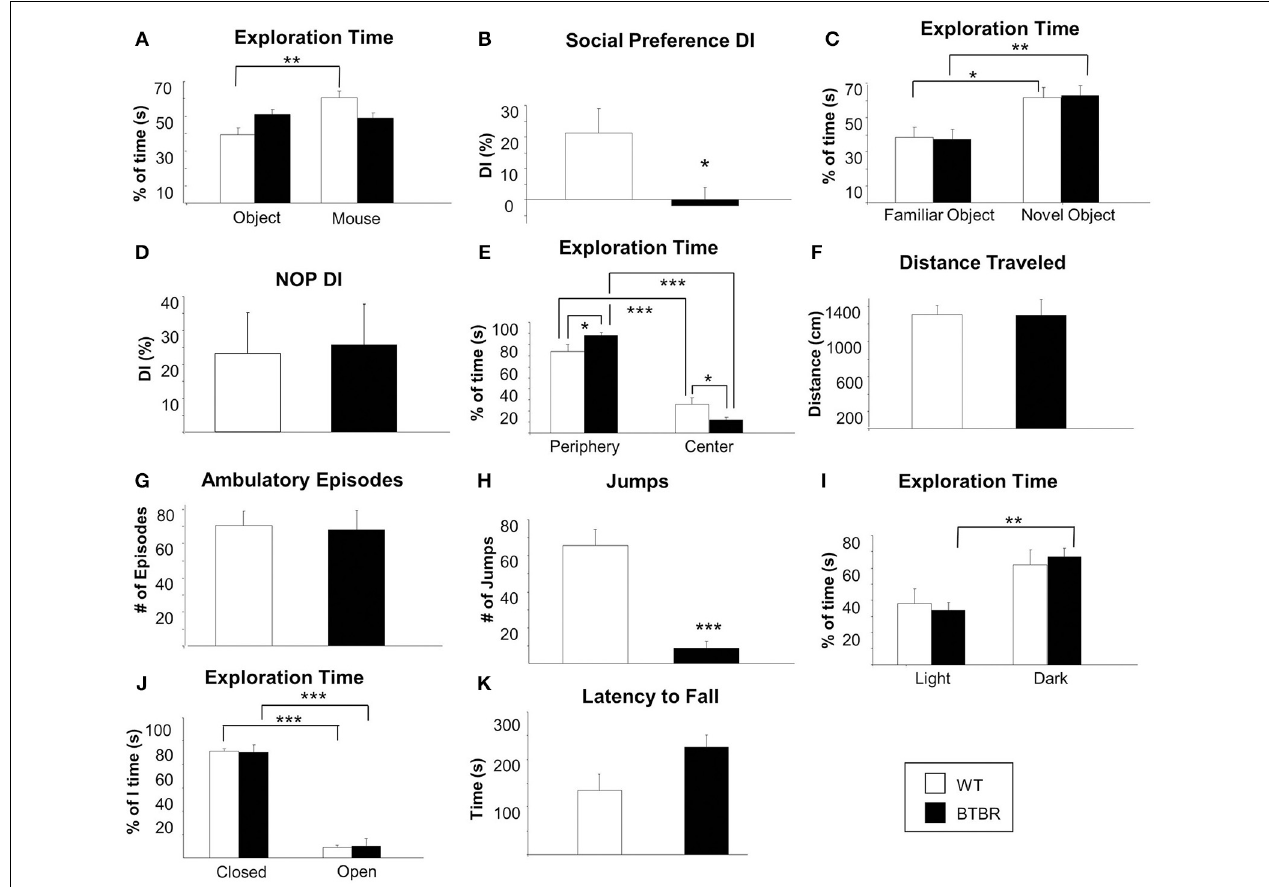
FIGURE 1 | Social function, cognitive ability, general behavior, anxiety and motor coordination in an aged ASD mouse model. Social preference was assessed using a three-chambered sociability apparatus in aged male BTBR T + tf/j mice and age-sex-matched control mice (A, B) . Percentage of time spent exploring both the contained inanimate object and the contained mouse was measured for male BTBR ( n = 8) and control mice ( n = 5) (A) . A discrimination index (DI) was calculated (B) which represents the degree to which experimental or control animals displayed a preference for exploring the contained mouse over the contained inanimate object. Cognitive functioning was assessed via the novel object preference task (NOP) (C, D) . Percentage of time spent exploring either a familiar or a novel object was again measured for male BTBR ( n = 8) and control mice ( n = 5) (C) and a DI was calculated (D) with a higher DI indicating an increased ability to discern a novel object from a familiar object. Exploration of an open field apparatus was